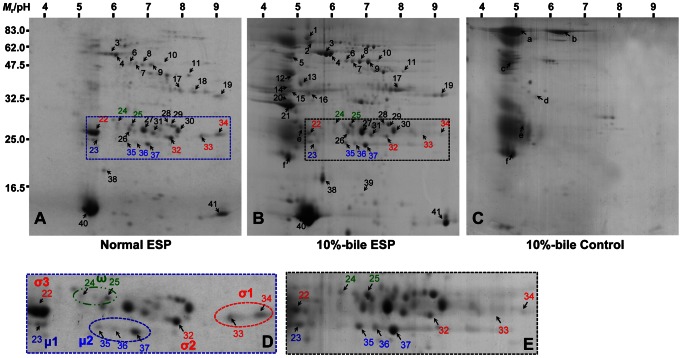
Two-dimensional proteomic array of C. sinensis ESP.One hundred worms were incubated in RPMI-1640 (normal ESP) or in RPMI-1640 containing 10% rabbit bile (10%-bile ESP) at 37°C for 1 h. ESP precipitated with 10% tricholoacetic acid/acetone were resuspended with rehydration buffer. (A) The normal ESP (200 µg proteins) was isoelectrofocused (pH 3–10) and further separated by 12% SDS-PAGE. (B) The 2-DE gel image obtained with loading of the equal protein amounts of the 10%-bile ESP. (C) The 2-DE analysis of the same volume of culture medium of dead worm in the presence of 10% rabbit bile. (D) and (E) Protein spots with significantly intensified or diminished in the presence of bile are indicated by boxes and are highlighted. Protein spots were visualized by CBB staining and further processed with MALDI-TOF MS or TOF-TOF identification. The spots identified are marked by an arrow and Arabic numeral (see also Table 1 and Table S1). Proteins identified as GST isoforms are marked by red (σ-class), blue (μ-class) and green (ω-class) letters.